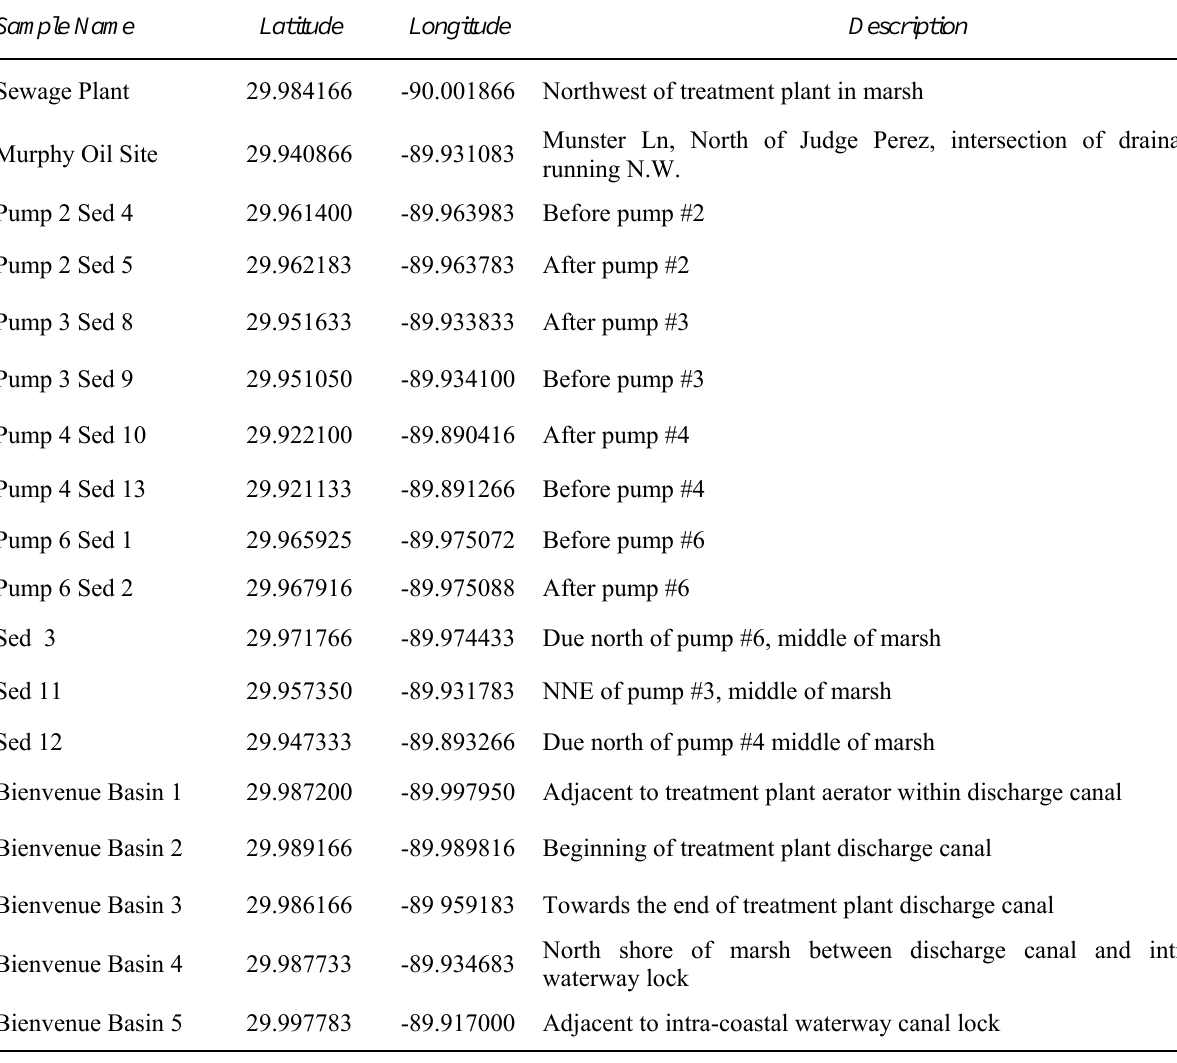
Table 1: Description of the sediment core locations in and around Violet